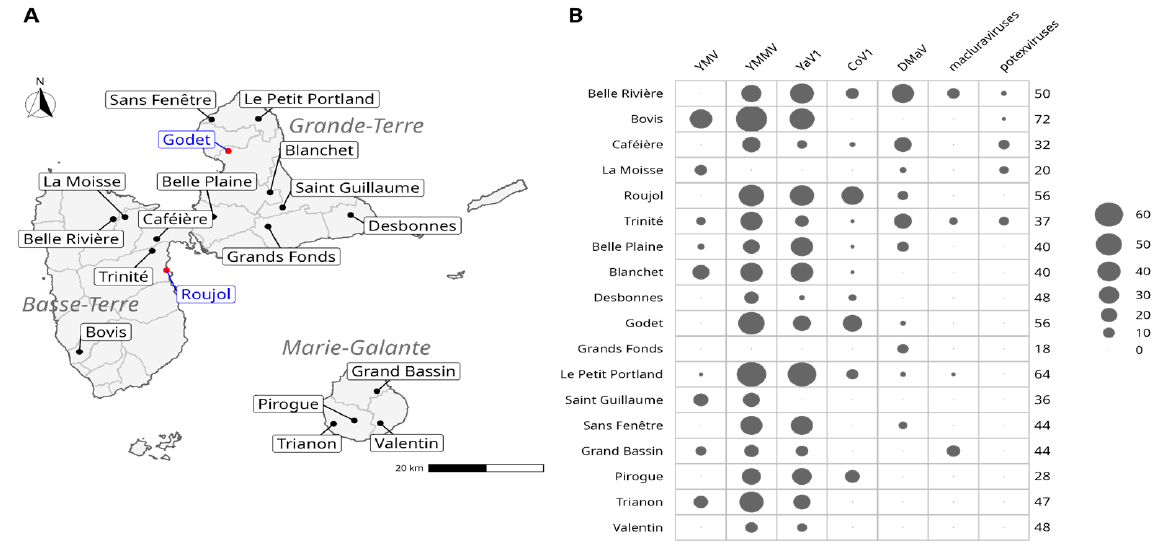
Figure 1. Sampling sites. ( A ) Location of the sampling sites. Sites indicated in blue were sampled both in 2019 and 2020, whereas those indicated in black were sampled in 2019 only. ( B ) Abundance (number of positive samples) of the viruses detected in yams collected from the 18 plots sampled in 2019. The size of the circles is proportional to the number of infected samples. The total number of indexed samples for each site is shown on the right of the table.